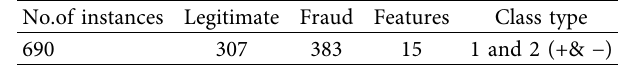
Table 2: Characteristics of the Australian credit dataset.